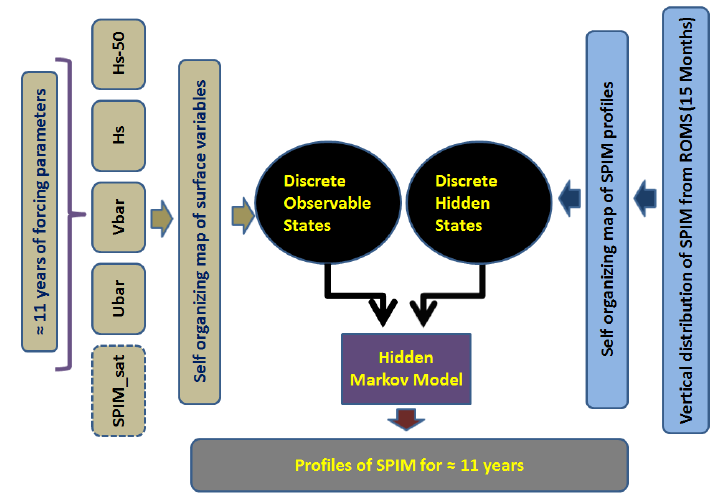
Figure 3. Schematic representation of the methodology. The observable variable shown in dotted outline is used only for the assimilation experiment (i.e., experiment